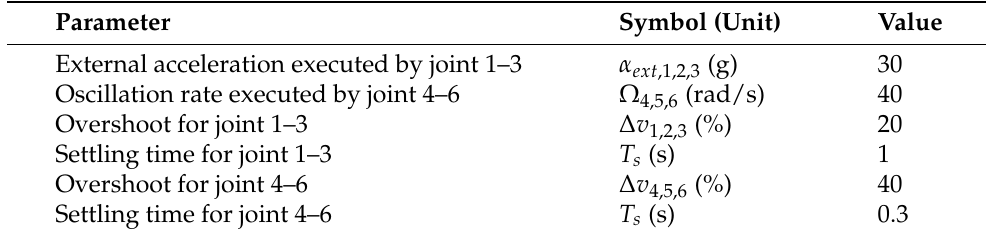
Table 2. Control requirements related to the desired system